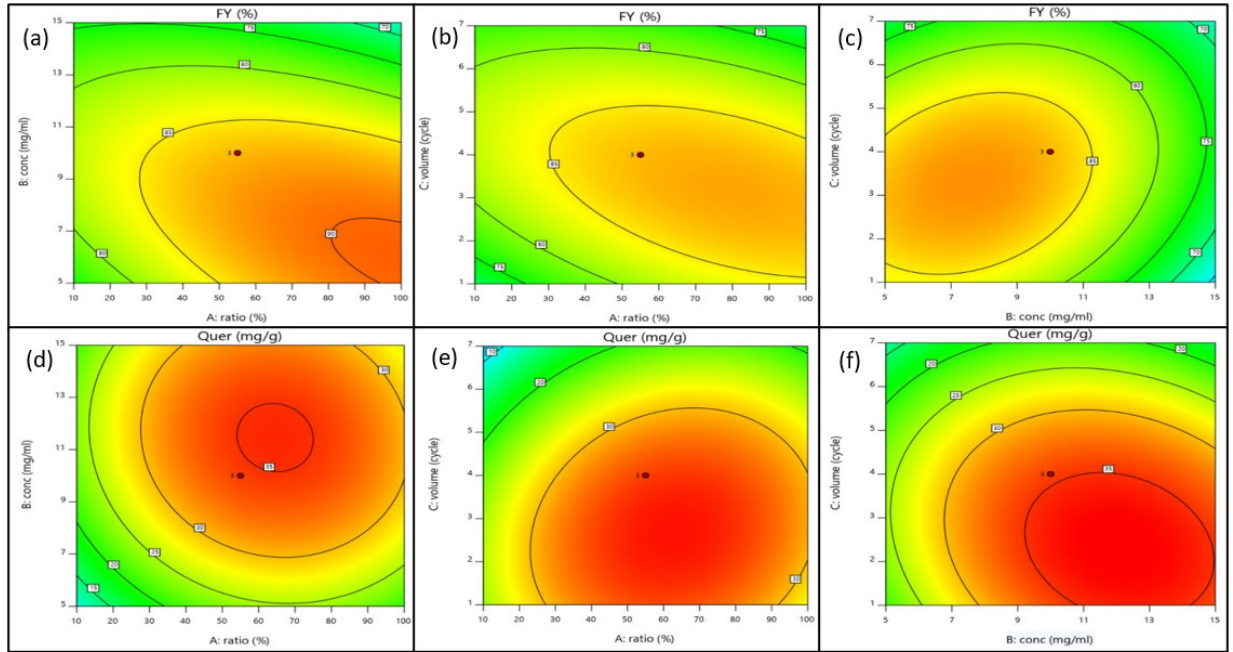
Figure 4. Two-dimensional contour plots of fraction yield (%) and quercetrin content (mg/g) resulting from the interactive effects of independent variables such as methanol concentration (A), loading concentration of crude extract (B), and volume of eluent expressed in cycle (C). ( a ) Contour plot of fraction yield resulting from the interaction of methanol concentration (A) and loading concentration of crude extract (B); ( b ) contour plot of fraction yield resulting from the interaction of methanol concentration (A) and volume of eluent expressed in cycle (C); ( c ) contour plot of fraction yield resulting from the interaction of loading concentration of crude extract (B) and volume of eluent expressed in cycle (C); ( d ) contour plot of quercetrin content resulting from the interaction of methanol concentration (A) and loading concentration of crude extract (B); ( e ) contour plot of quercetrin content resulting from the interaction of methanol concentration (A) and volume of eluent expressed in cycle (C); ( f ) contour plot of quercetrin content resulting from the interaction of loading concentration of crude extract (B) and volume of eluent expressed in cycle (C).